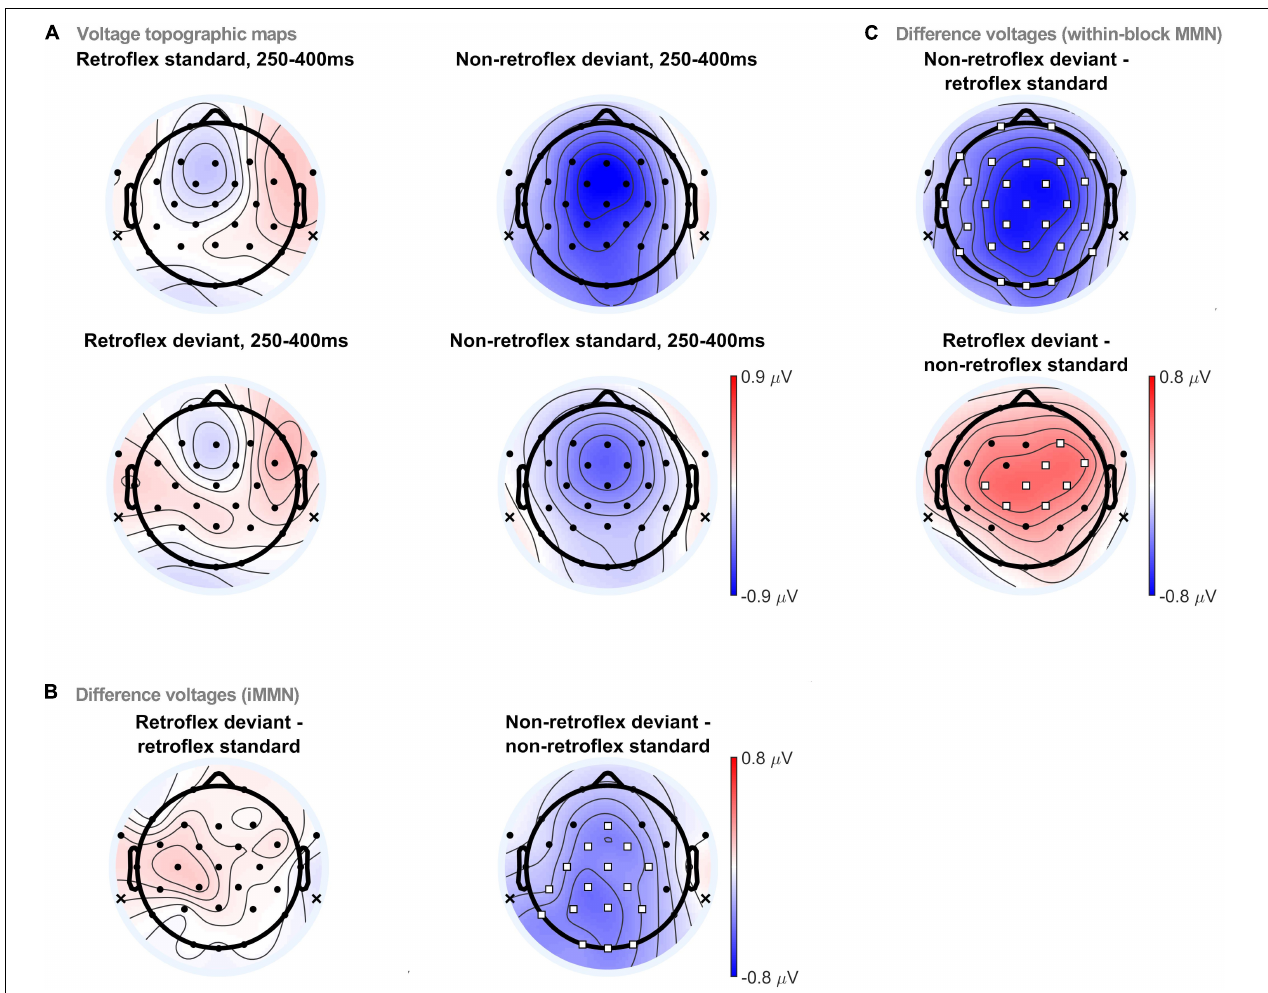
FIGURE 4 | (A) Voltage topographic maps for retroflex/non-retroflex standard/deviant at 250–400 ms. Difference voltage topographic maps and the permutation test results for (B) within-block MMNs, (C) iMMNs. Electrodes highlighted in white squares denote electrode sites with significant differences using a permutation test (pFDR < 0.05). Topographic analyses were carried out with a linked mastoid reference. The reference locations are marked with an ‘x’ on the topographic